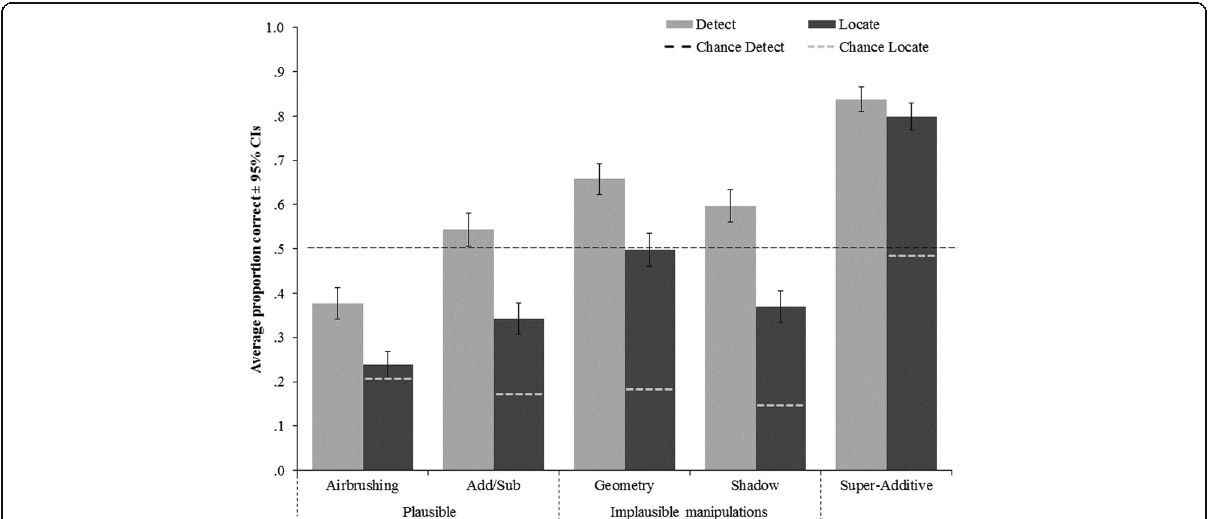
Fig. 3 Mean proportion of correct “ detect ” and “ locate ” decisions by type of photo manipulation. The dotted line represents chance performance for detection. The grey dotted lines on the locate bars represent chance performance by manipulation type in the location task. Error bars represent 95% CIs